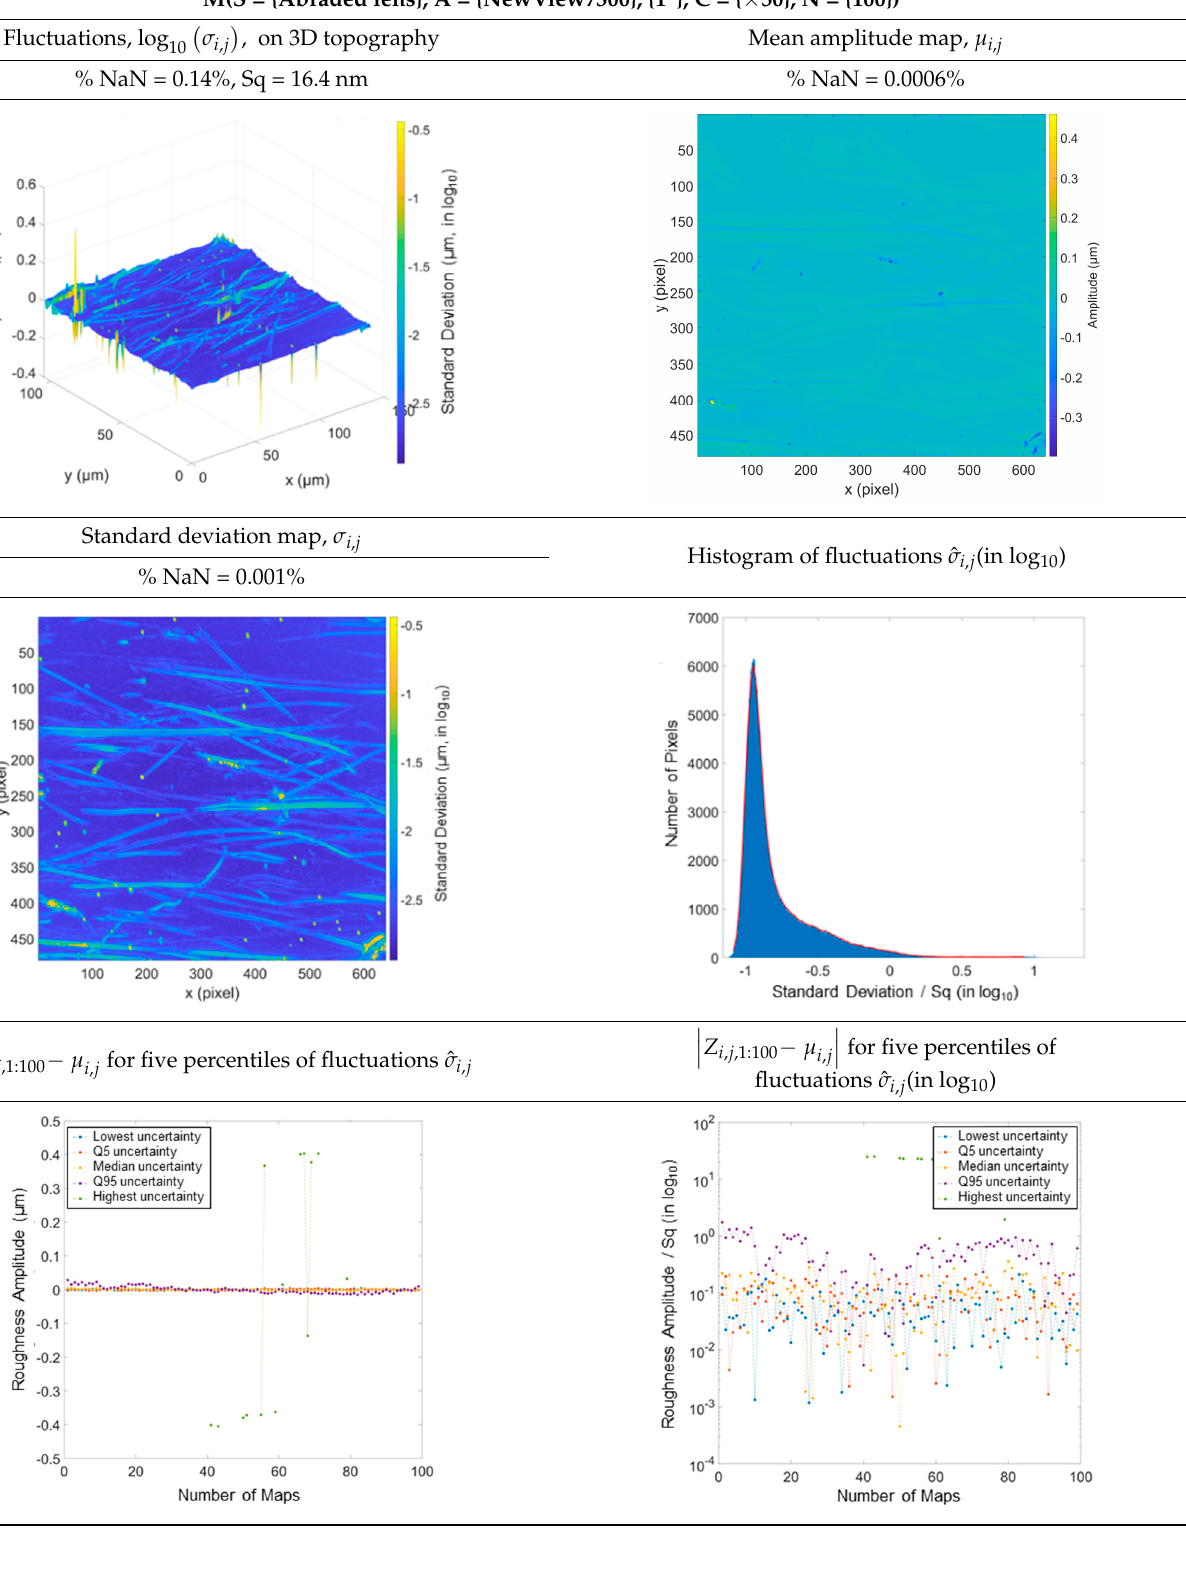
Table A4. Abraded Ophthalmic Lens (Essilor), Location n°2